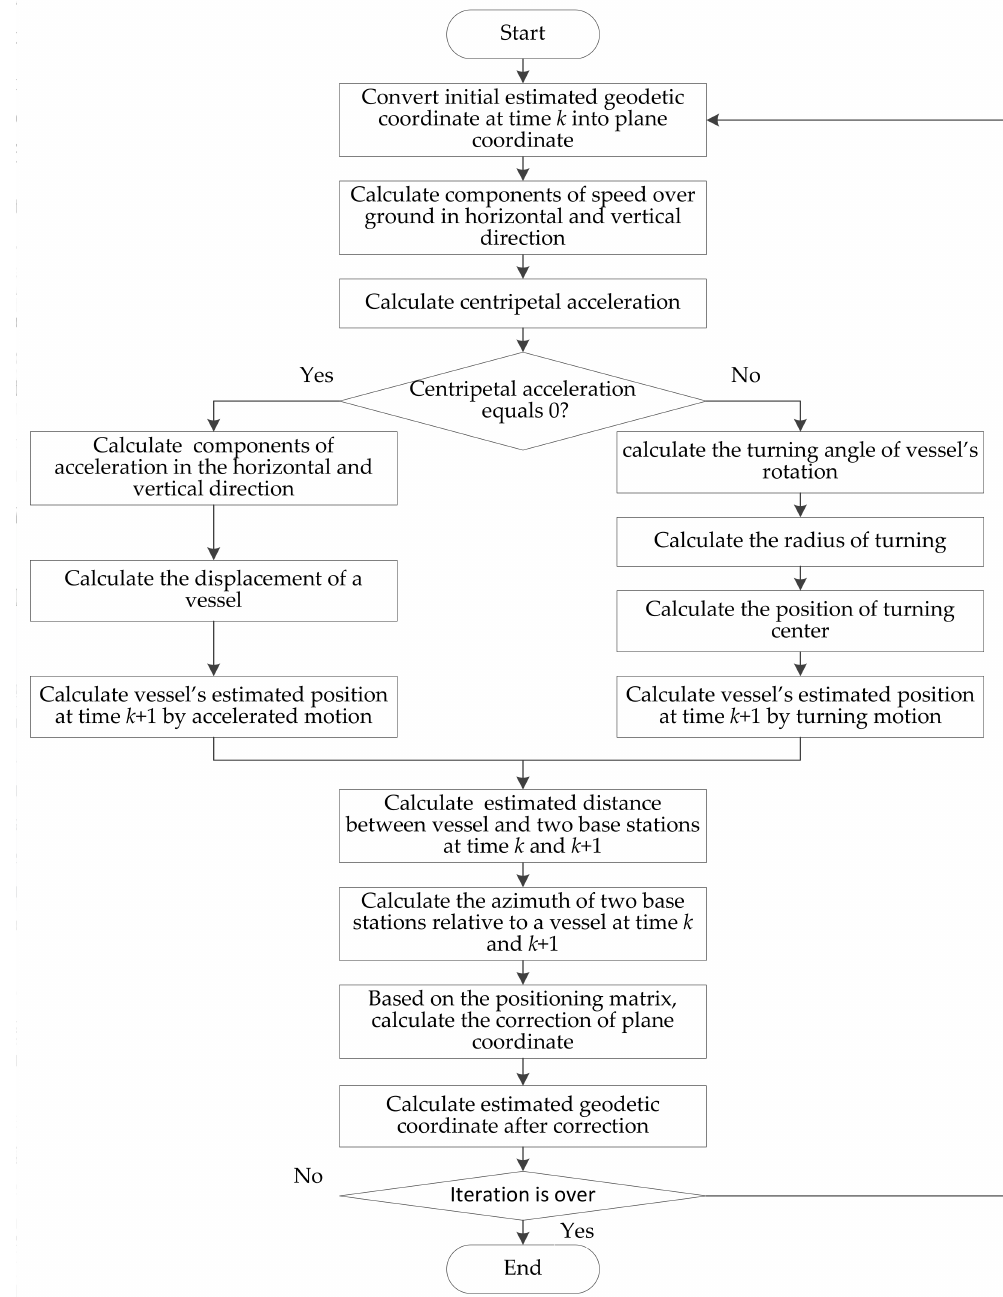
Figure 4. Flowchart of the improved displacement correction position estimation (DCPE)